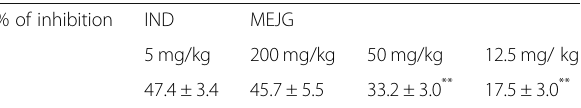
Table 2 Anti-inflammatory activity of MEJG in chronic TPA- induced